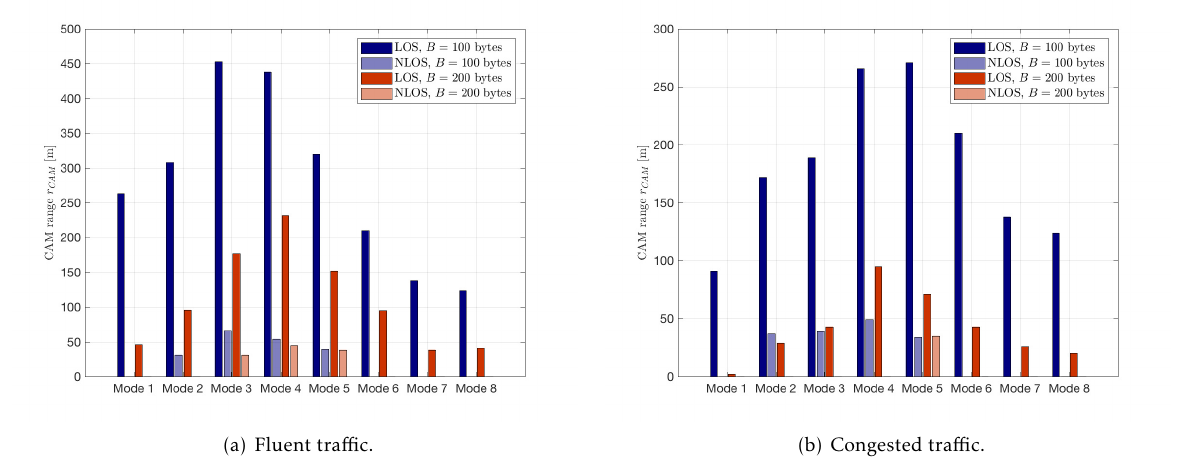
Figure 4. Maximum distance to have CAM delivery rate above 90% for the eight